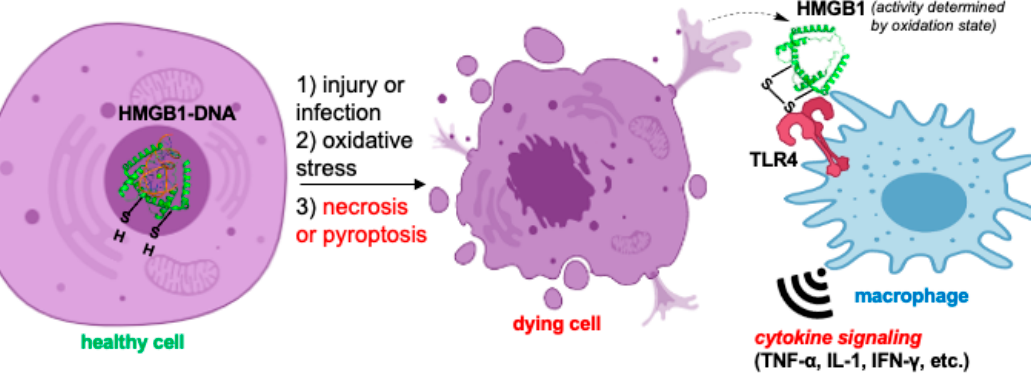
Figure 2. Inflammatory signaling driven by HMGB1. A damaged cell can undergo oxidative stress, resulting in oxidation of HMGB1 to its various disulfide forms, release from DNA and chromatin, and passive diffusion from a dying cell. It is subsequently recognized by TLRs and RAGE in immune cells and other cell types, initiating inflammatory signaling.